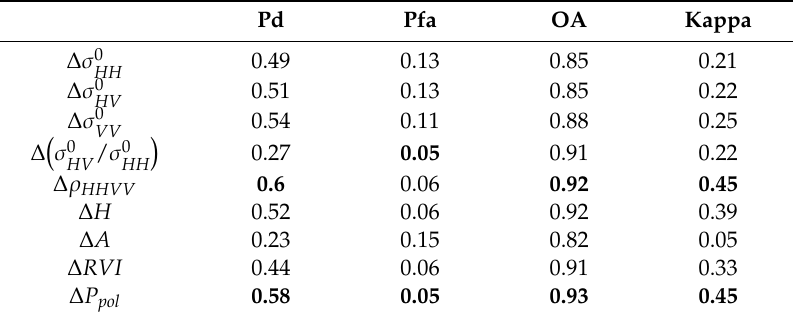
Table 2. Detection accuracies for the di ff erent polarimetric parameters.